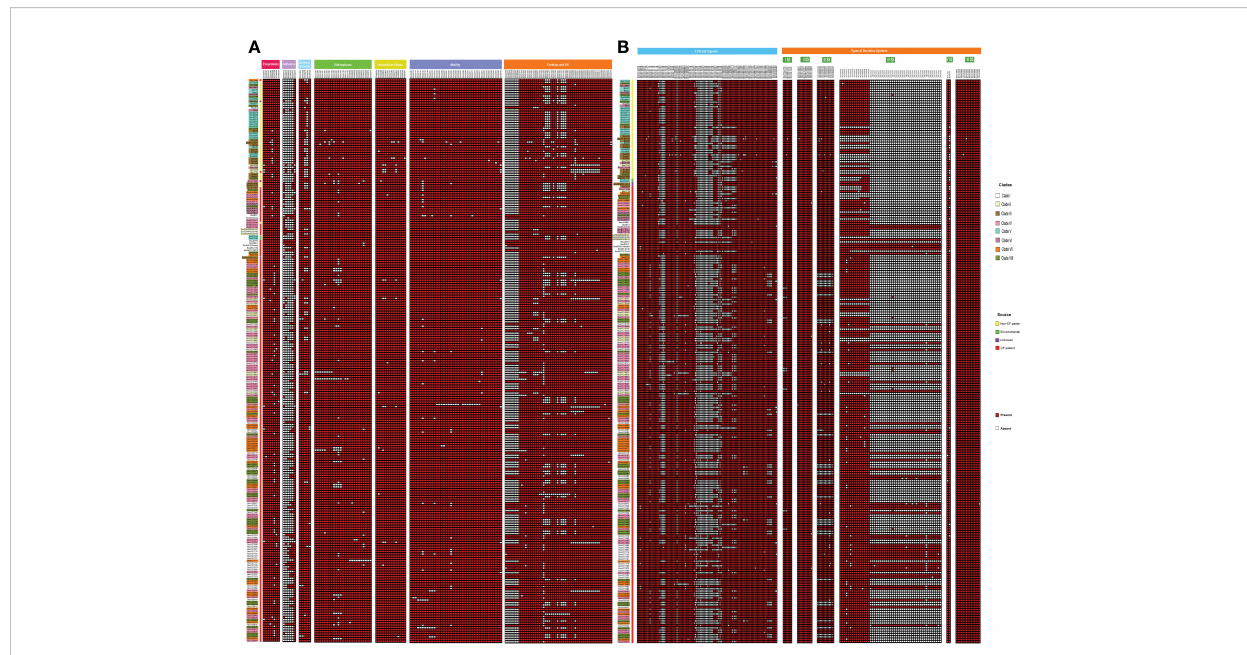
FIGURE 5 Heatmap depicting the virulence pro fi le of 245 CC31 isolates. Red square box represents presence of virulence genes belonging to different categories. (A) Exoproteins, Adhseins, Quorum sensing, Siderophores, Motility, Fimbriae and pili. (B) LPS capsule, other capsules, and secretion